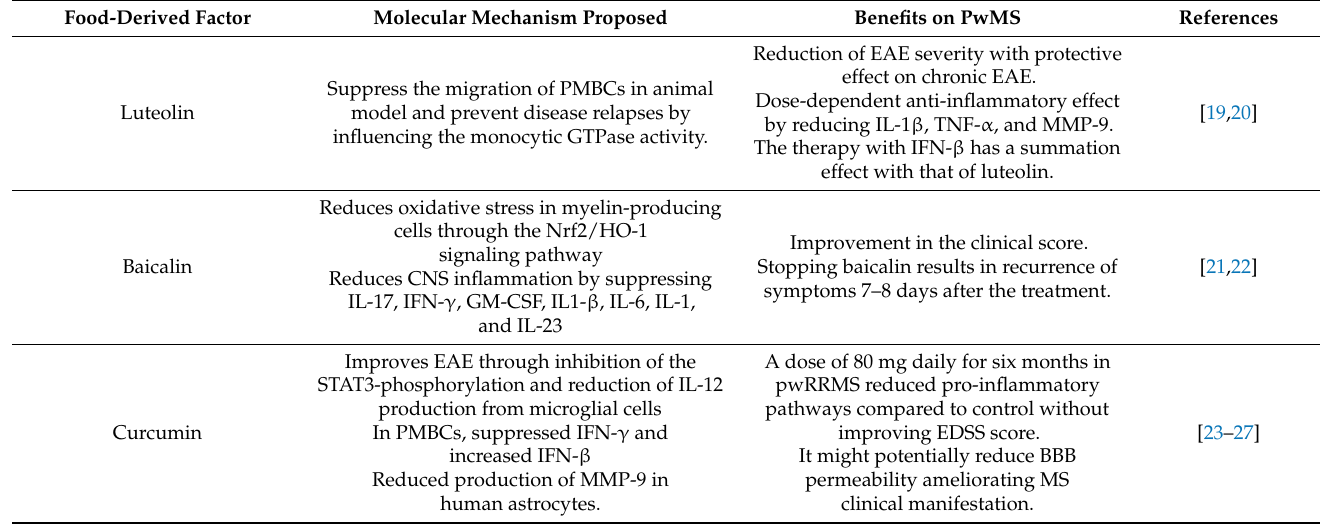
Table 2. Molecular mechanism and possible advantages on pwMS of food-derived polyphenols. Food-Derived